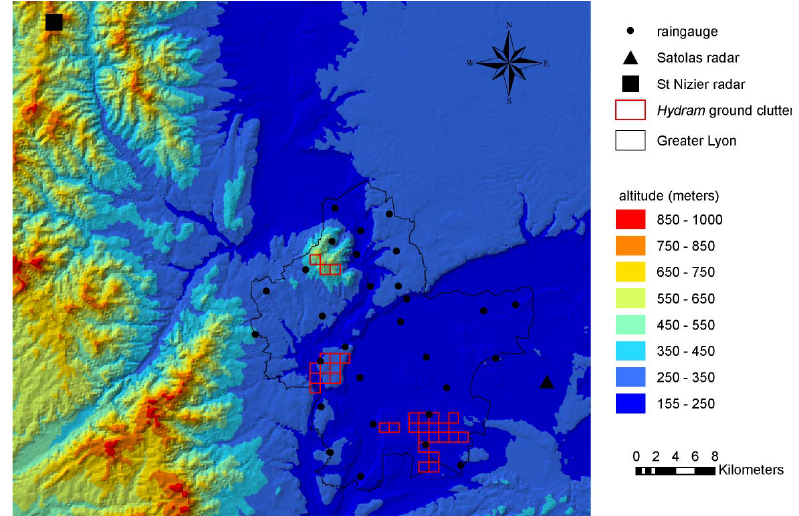
Fig. 1. Radar sites over the Greater